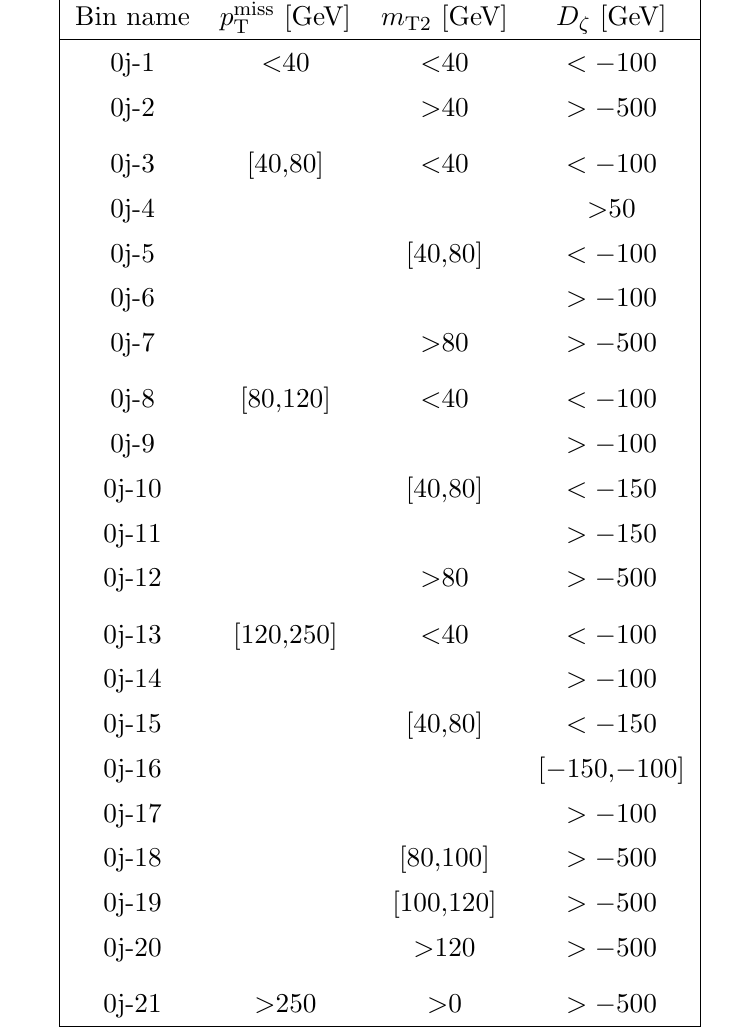
Table 4. De(cid:12)nition of SRs in the 0-jet category for the e (cid:28) In the leptonic (cid:12)nal states, events satisfying the baseline selection criteria are catego- rized into SRs based on a series of thresholds applied to the values of the discriminating observables p miss